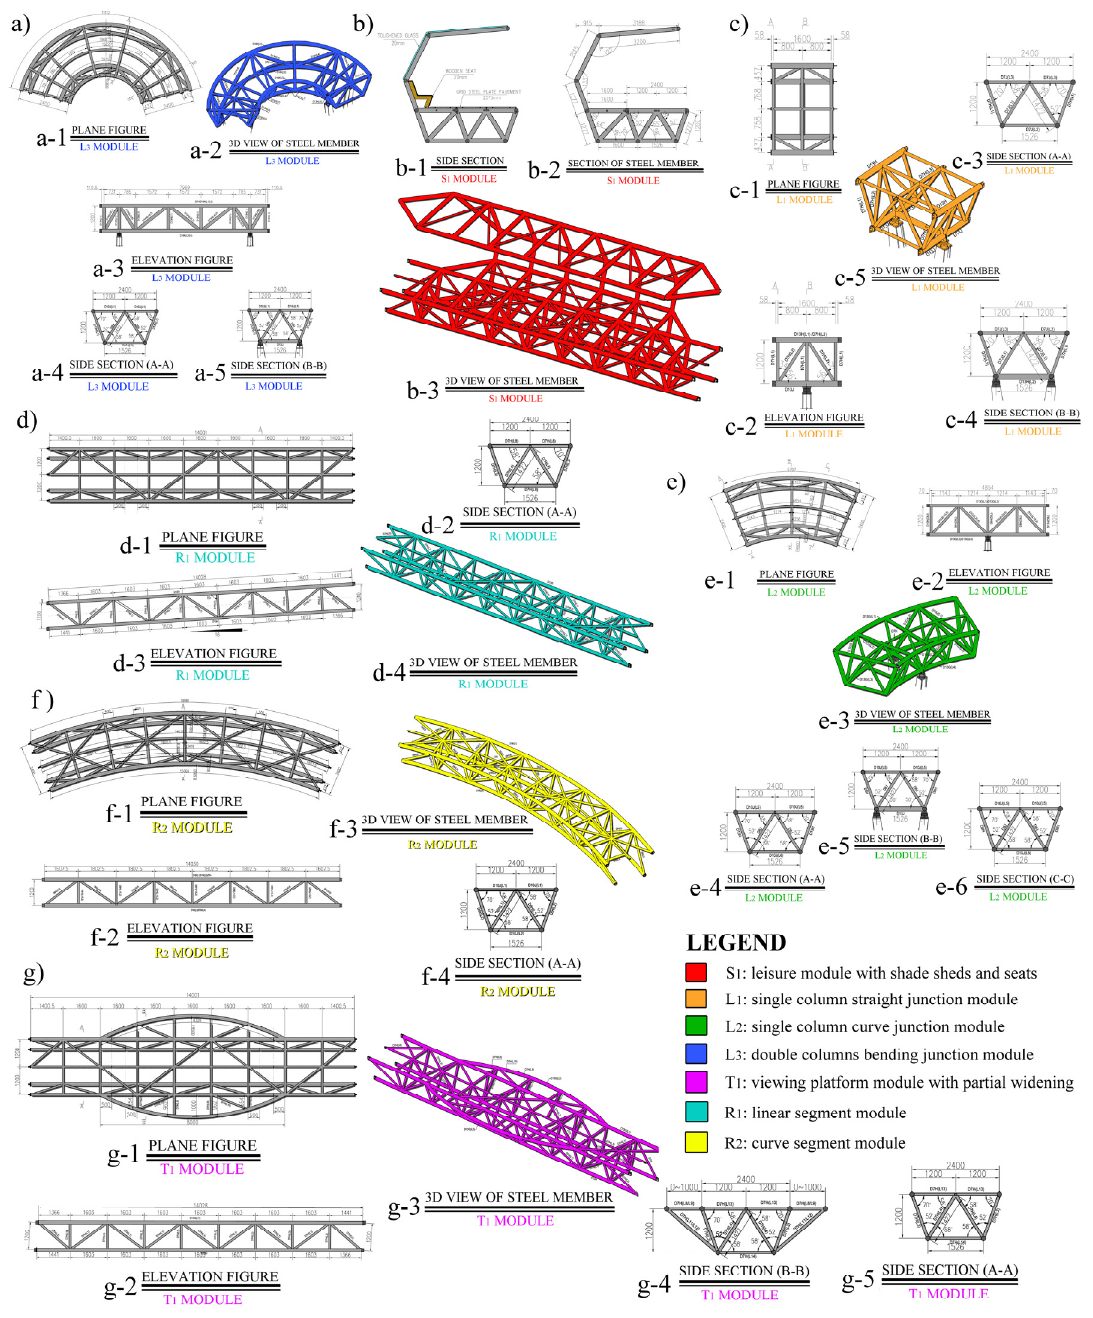
Figure 5. The structural design drawings of seven modules of the Fu Forest Trail: ( a ) The L 3 module; ( b ) the S 1 module; ( c ) the L 1 module; ( d ) the R 1 module; ( e ) the L 2 module; ( f ) the R 2 module; and ( g ) the T 1 module (Source: author remade according to reference [22]).